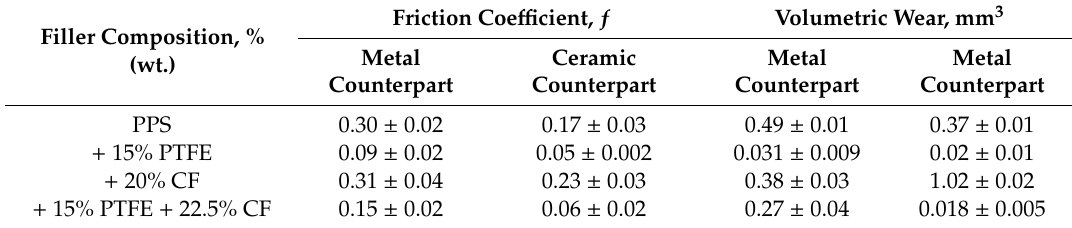
Table 6. Tribological properties of PPS, as well as the PPS-based two- and three-component composites. Friction Coe ffi cient, ƒ Volumetric Wear, mm 3 Filler Composition, % Metal Ceramic Metal Metal (wt.) Counterpart Counterpart Counterpart